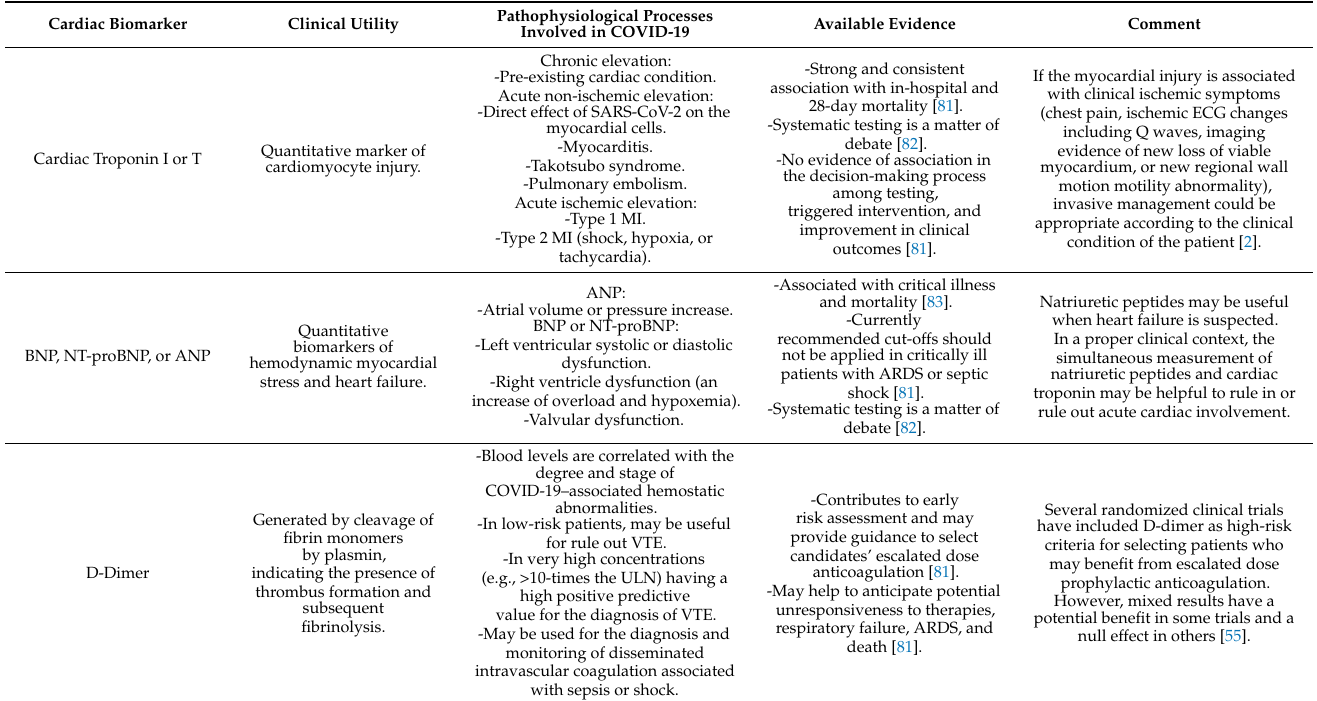
Table 1. Main cardiac biomarkers used in clinical practice in patients with